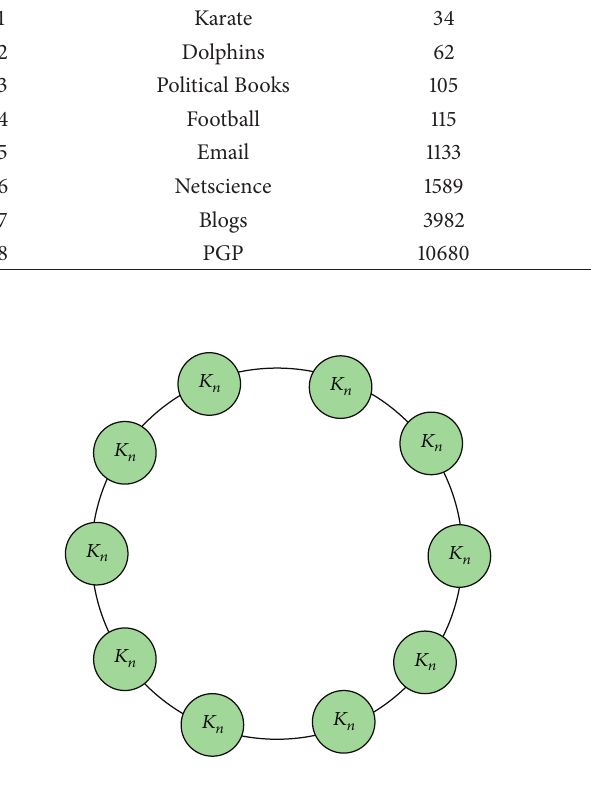
Figure 5: The structure of Clique-Ring